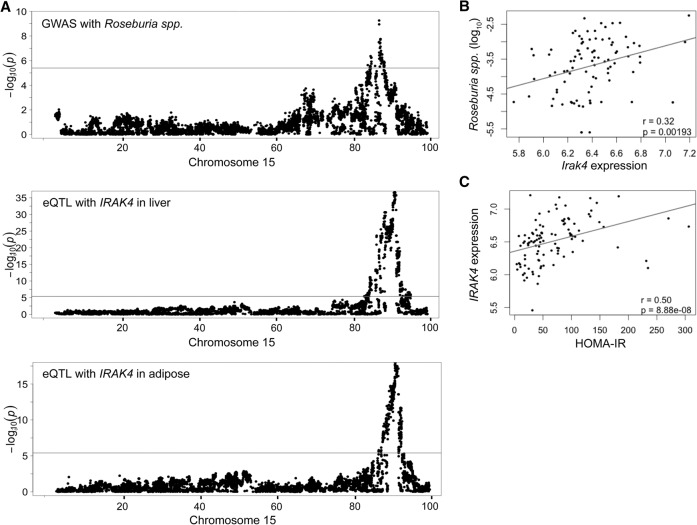
Chromosome 15 locus for abundance of genus Roseburia spp. (A) Overlapping genome-wide significant associations with the abundance of Roseburia spp. and liver and adipose eQTLs of the Irak4 gene in HMDP mice fed a HF/HS diet. The horizontal line indicates the threshold for genome-wide significance (P < 4 × 10−6). (B,C) Correlations of Irak4 adipose gene expression with the relative abundance of Roseburia spp. and HOMA-IR in the HMDP mice. (r) Biweight midcorrelation, (p) P value. See also Supplemental Tables 6 and 7.